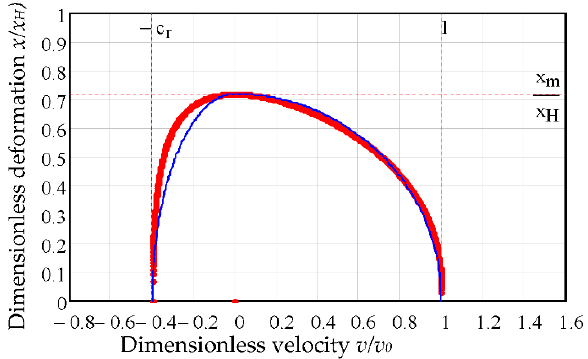
Figure 5. Trajectory of characteristic point in phase space.